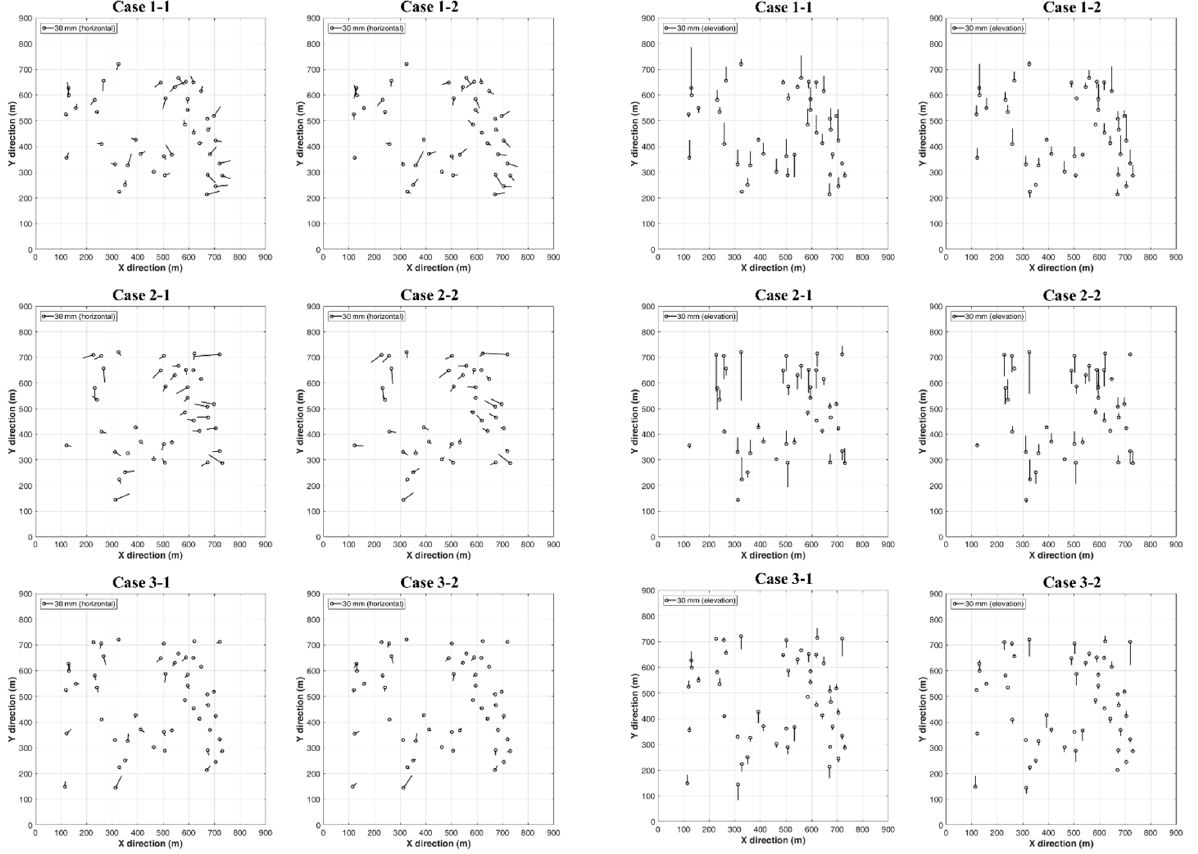
Figure 7. The horizontal coordinate difference vectors (left) and elevation difference vectors (right) on all